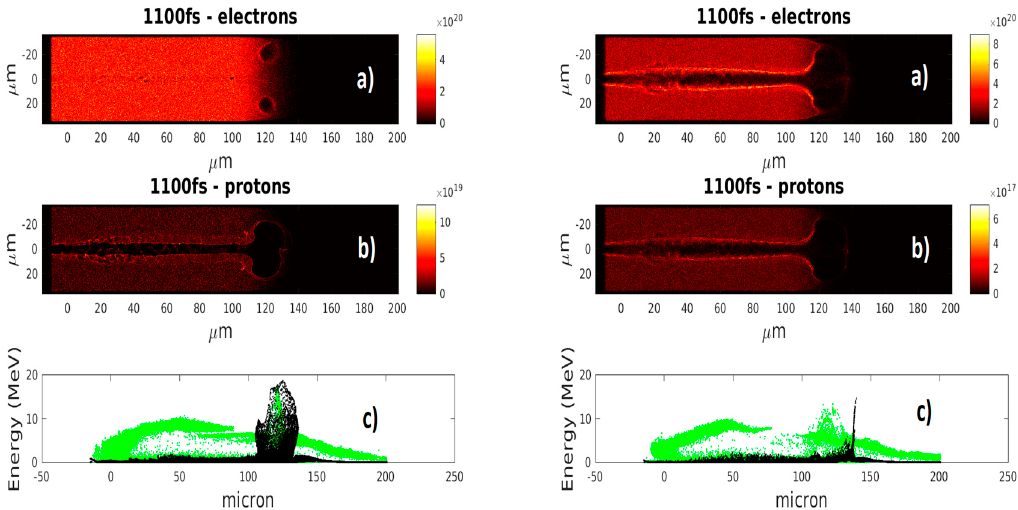
Figure 6. Shows the snapshots of the laser-plasma interactions, considering a fully-ionized artificial specie with Z = 1 and A = 131 that we call “low charge specie”, in a mixture of 95% “low charge specie”–5%H (left) and a fully-ionized artificial specie with Z = 131 and A = 131 that we call ”high charge specie”, in a mixture of 95% “high charge specie”–5%H ( right ) plasma simulated by 2D PIC after 1100 fs from the pulse entry ( − 20 μ m) in the simulation box (so that the laser pulse has already left the simulated model’s area). The total electron density is set to be 2 × 10 20 e − /cm 3 , and the plasma profile considered is the same. The electrons’ (frames a ) and protons’ (frames b ) density distributions are shown with the protons’ (black) and electrons’ (green) energies versus the laser propagation direction (frames c ).